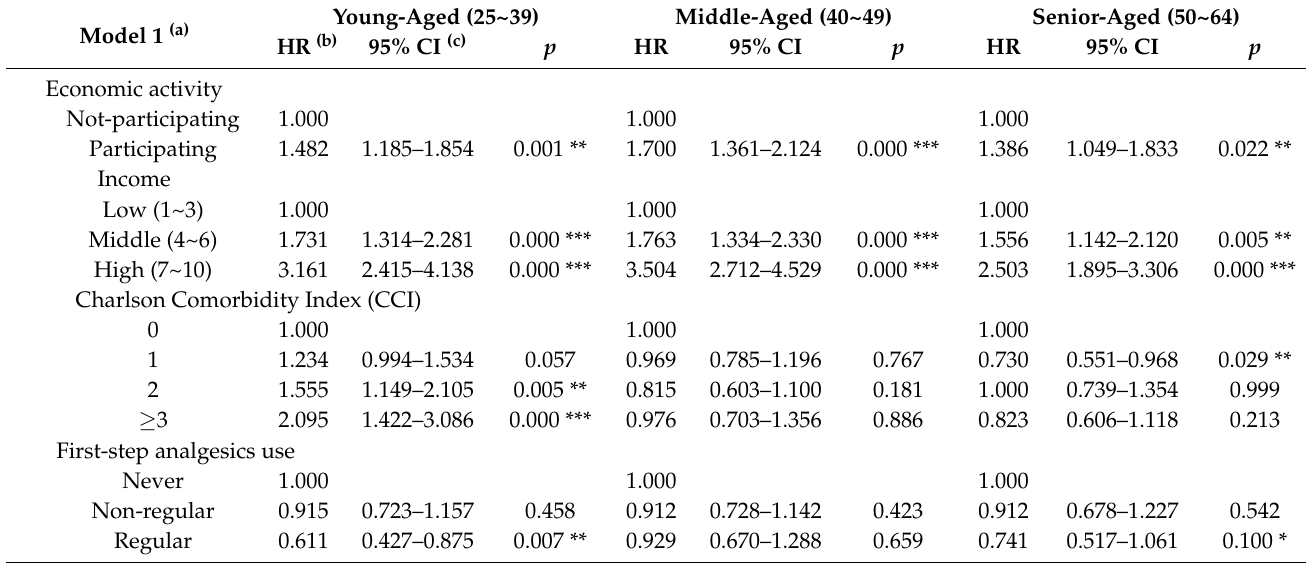
Table 3. Risk of breast cancer by specific working-age